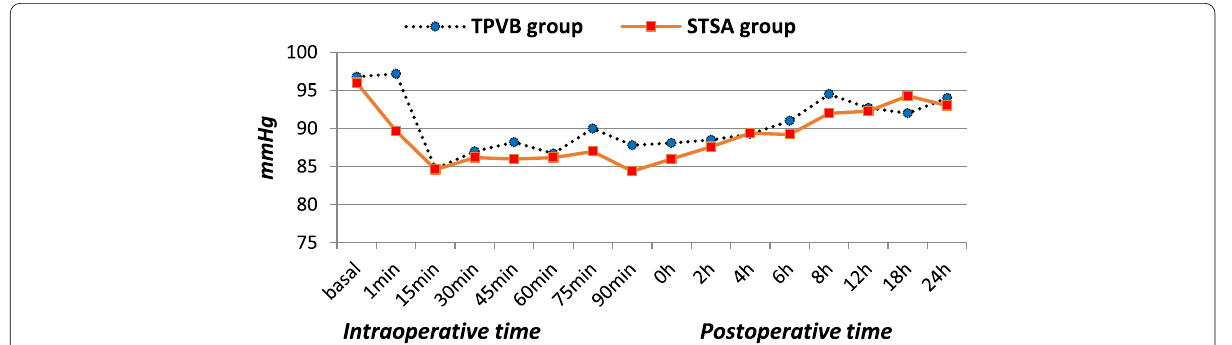
Fig. 2 Perioperative mean blood pressure (mmHg) of the two studied group